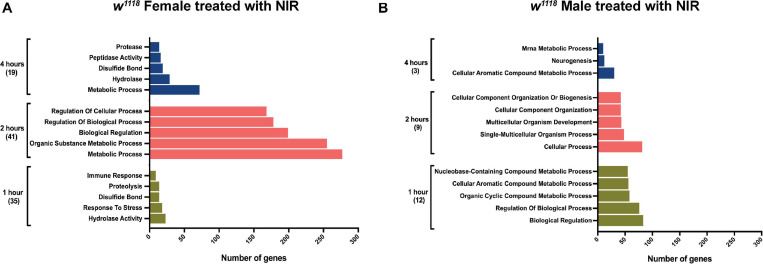
Gene ontology (GO) enrichment in w1118 injured flies exposed to NIR. Significant genes (| log2FC| > 1; p-value < 0.05) identified from sequencing were classified for their biological functions using RDAVID. The plot shows top five biological processes enriched in injured females (A) and males (B) after NIR exposure at each time-point. The total number of GO terms differentially regulated at each time-point is indicated in parenthesis.